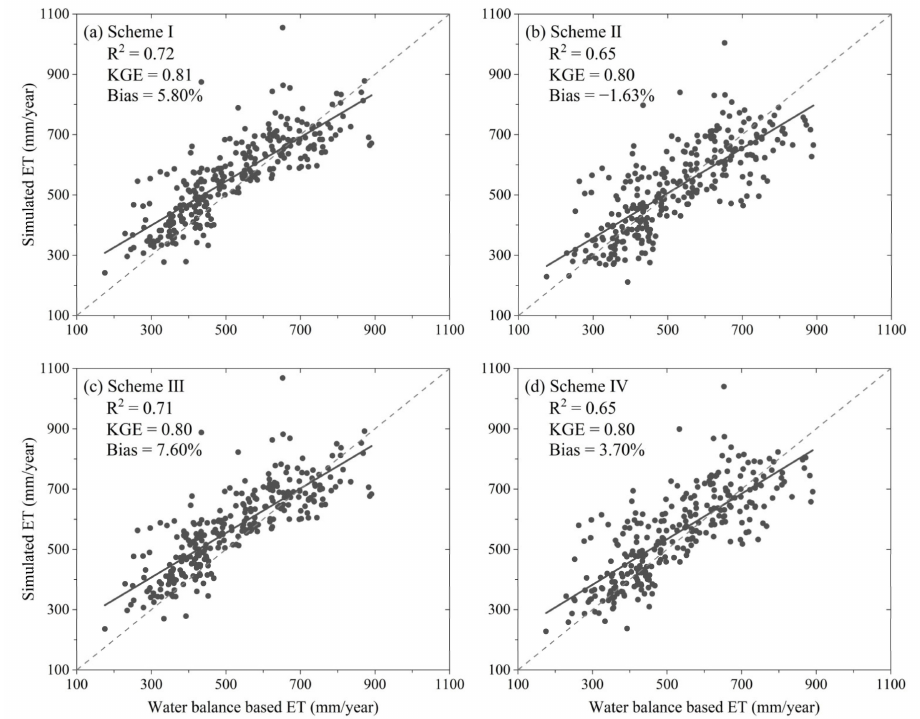
Figure 8. Scatterplots of simulated versus water balance-based mean annual ET at 286 test basins from 1982 to 2000. The dots represent mean annual ET of test basins; the solid line represents the regression line; the dashed line represents the 1:1